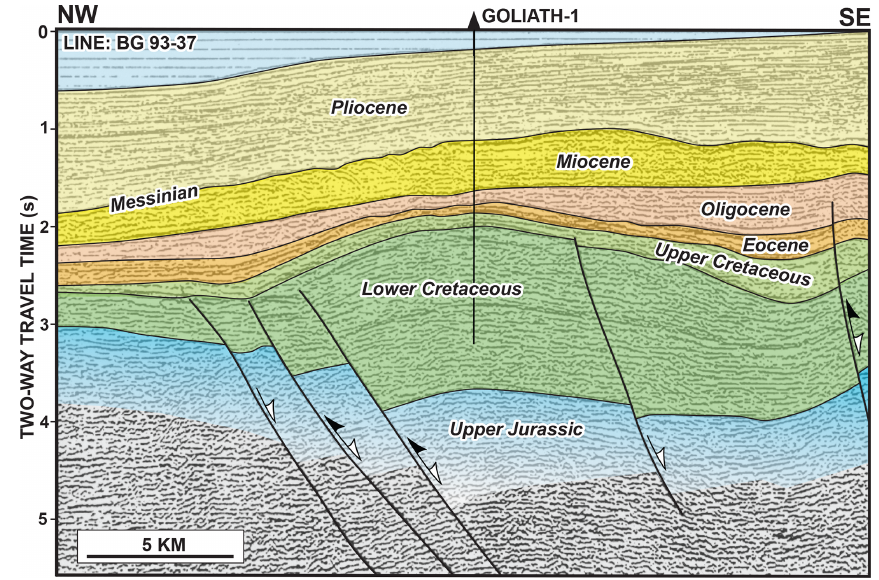
Figure 10. Two-dimensional reflection seismic profile across the Goliath anticline offshore Sinai, Egypt (see location in Fig. 8). The large syn-rift master fault controlled the deposition of the Lower Cretaceous sequence. The subsequent Late Cretaceous to Paleogene Syrian Arc inversion I is responsible for the formation of the asymmetrical anticline (adapted from Ayyad and Darwish,